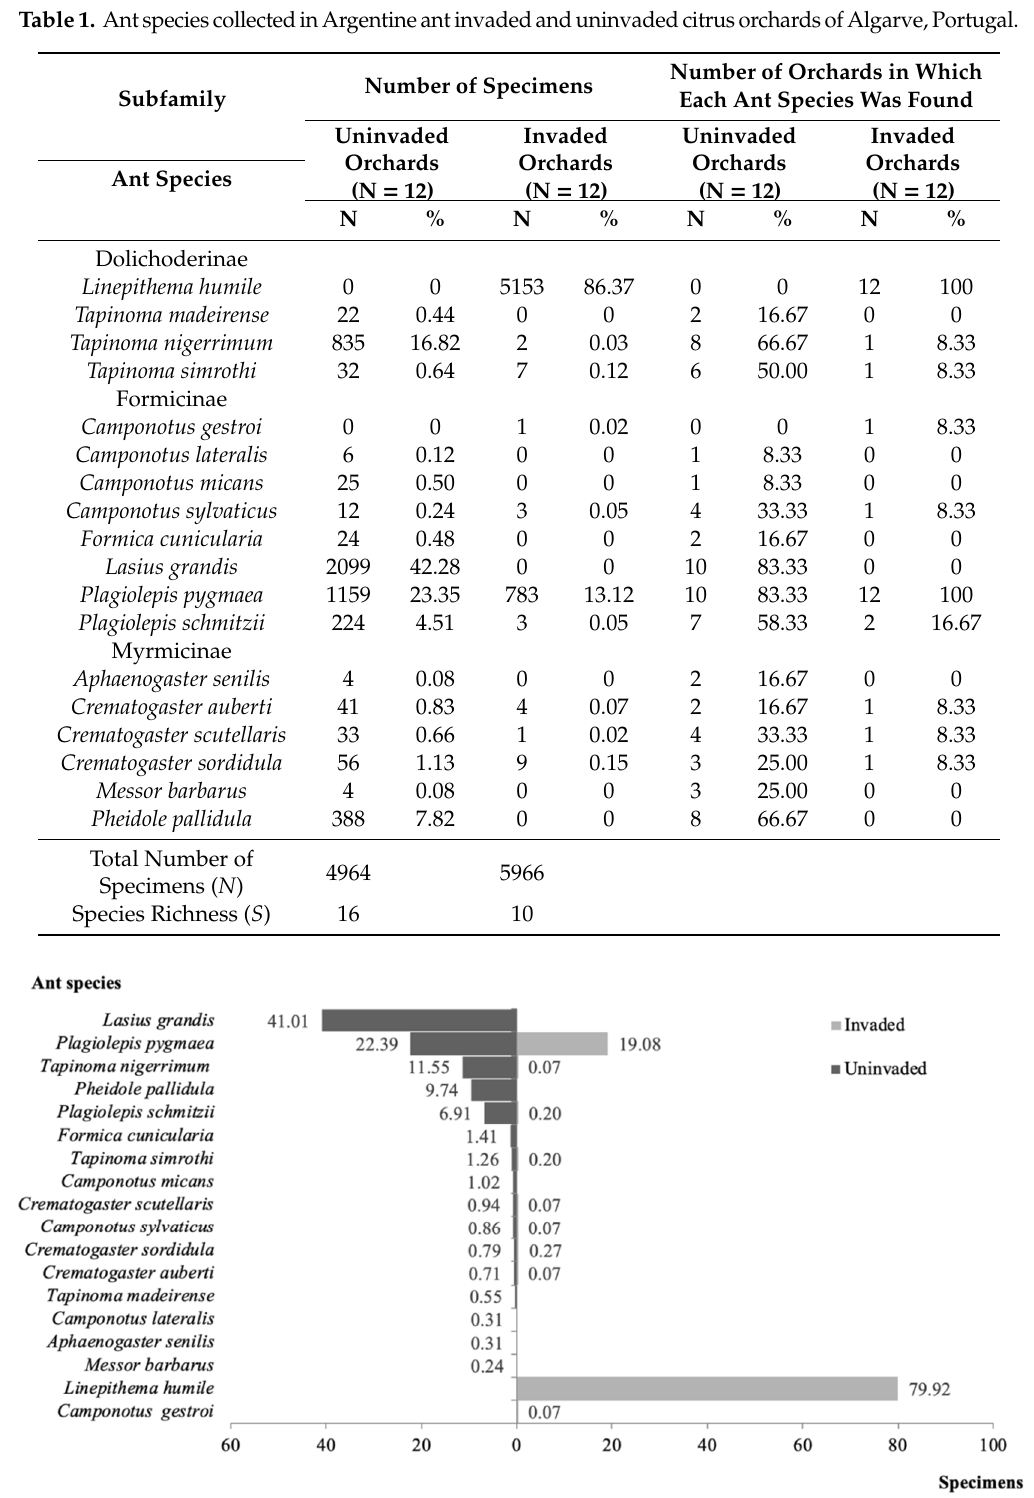
Figure 2. Frequency distribution (%) of ant species in Argentine ant invaded and uninvaded orchards.